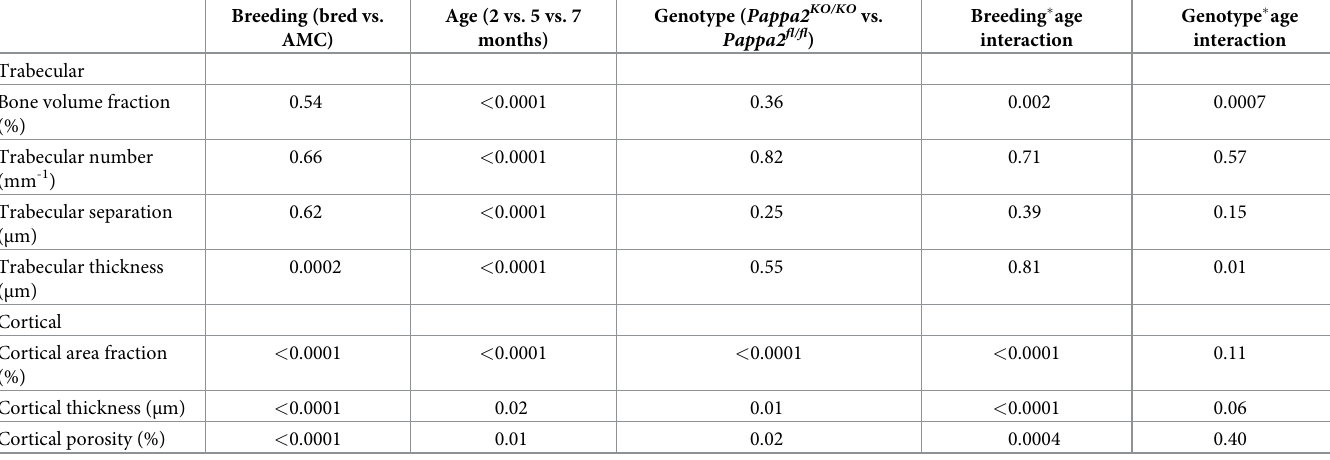
Table 4. Effects of age and Pappa2 genotype on the recovery of skeletal traits in 2, 5 and 7 month old mice, including only mice collected 3 weeks after weaning.